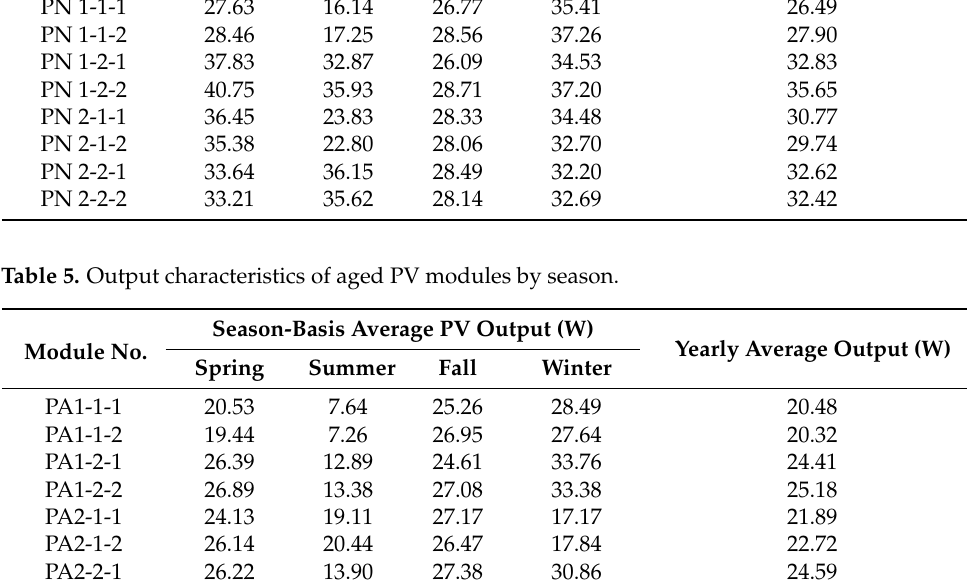
Table 4. Output characteristics of new PV modules by season. Module No.